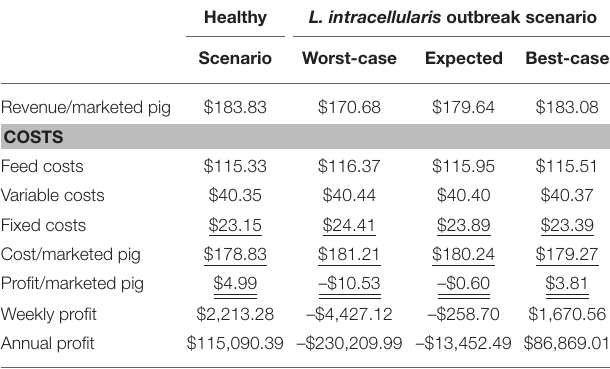
TABLE 6 | Financial Impact of Lawsonia intracellularis per marketed hog on a farrow-to-finish swine farm with 1,000